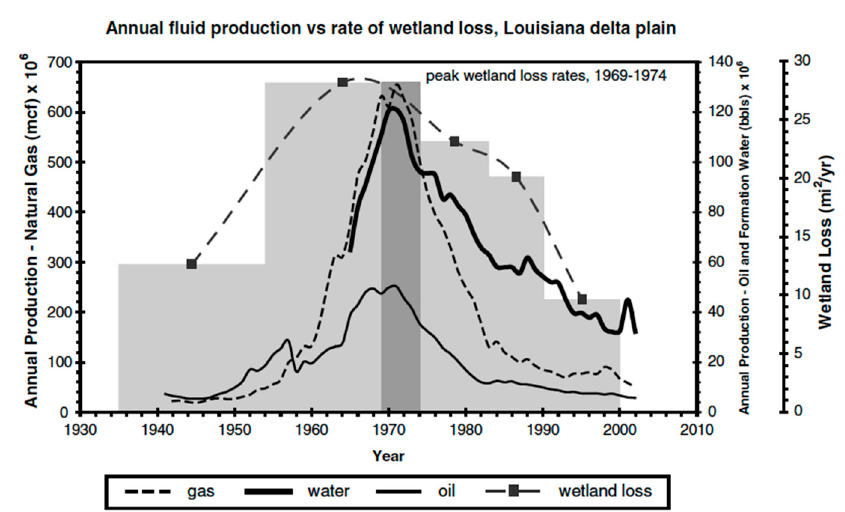
Figure 3. Composite histories of fluid production from oil and gas fields and wetland loss in south Louisiana. Production data from the Louisiana Department of Natural Resources and the PI/Dwights PLUS database [31]. Wetland loss values were determined by [32] and John Barras (unpublished data). These historical data, integrated across the delta plain, show close temporal and spatial correlations between rates of wetland loss and rates of fluid production [30]. Note that “water” in the legend refers to produced water.